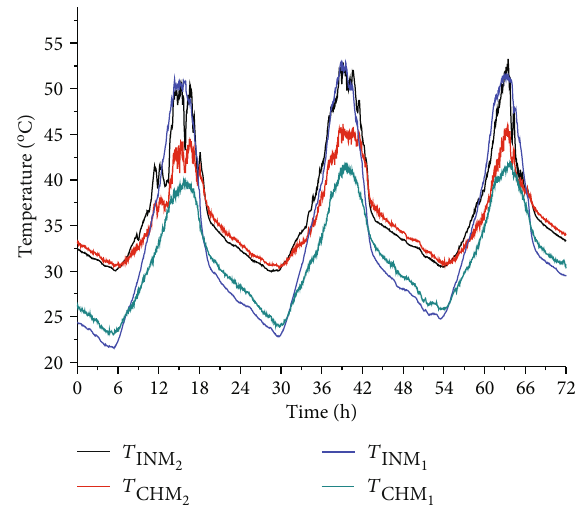
Figure 8: Inner side temperatures of PV cell and of the passage in the middle